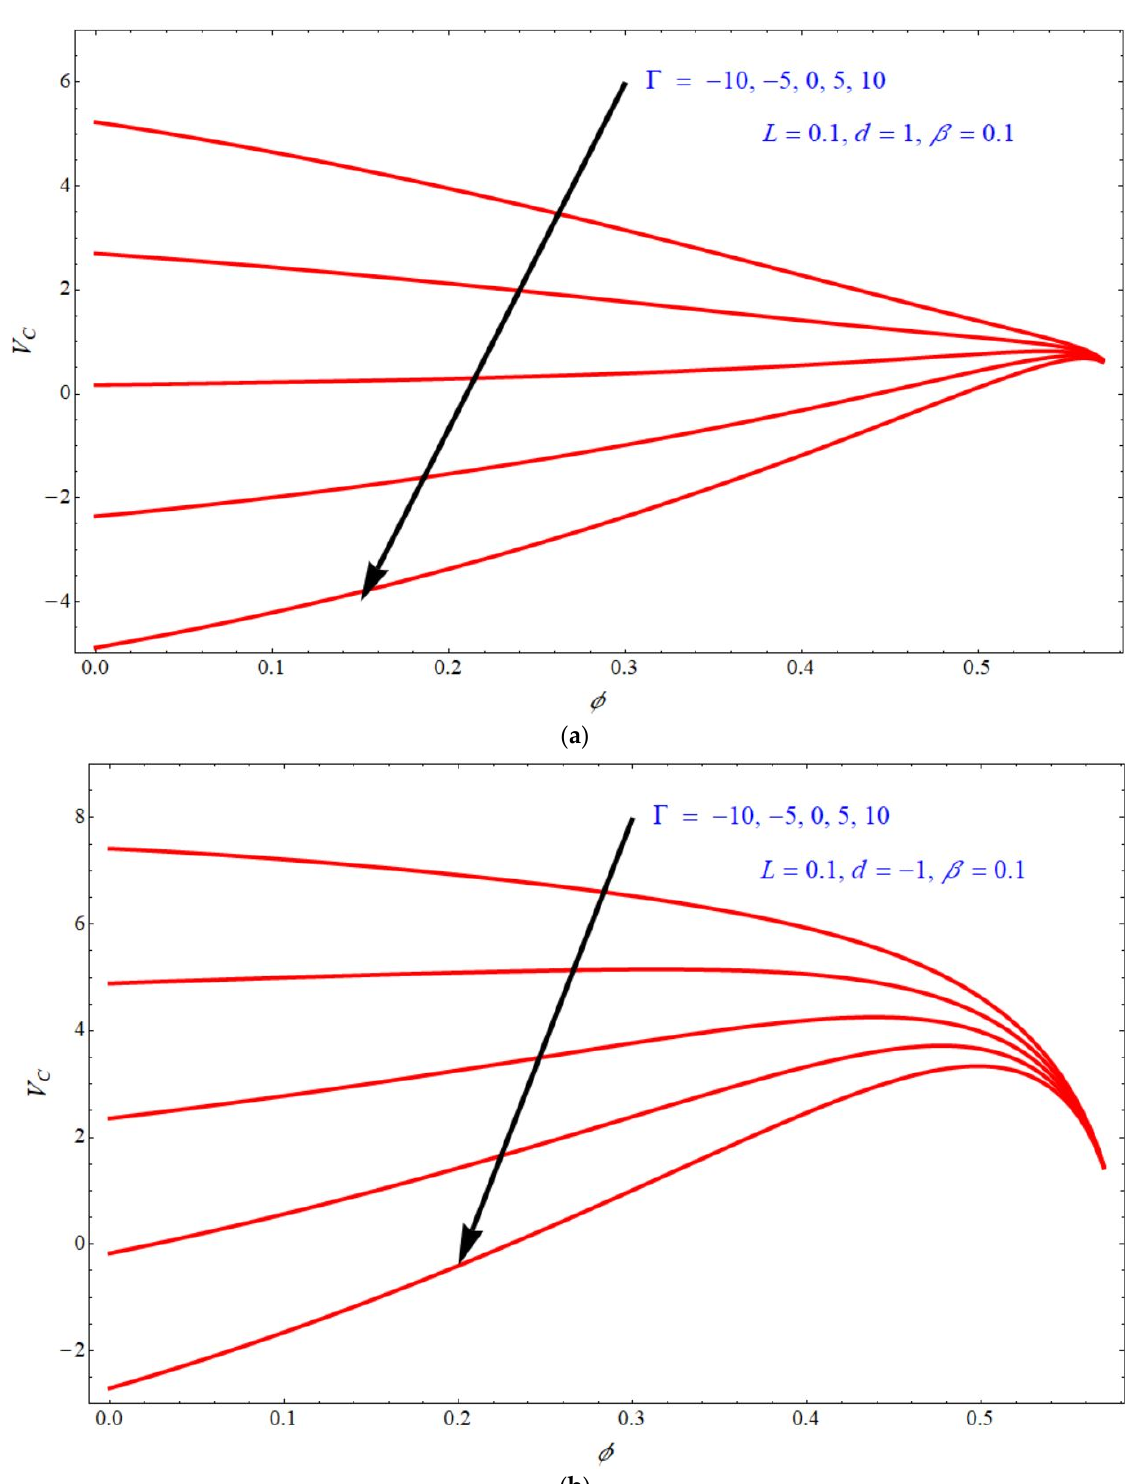
V on φ for various choices of Γ at ( a ) 1 d = and ( b ) 1 d = − . Figure 8. Impact of V c on φ for various choices of c